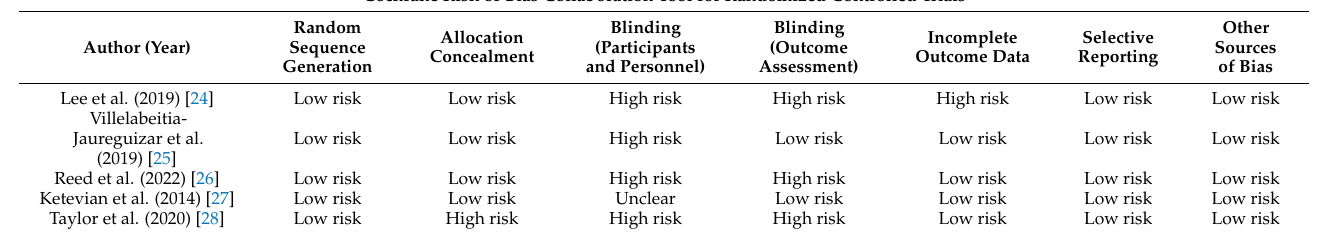
Table 3. Methodological quality evaluation of the clinical trials using the Cochrane Risk of Bias Tool for assessing the risk of bias in randomized trials.